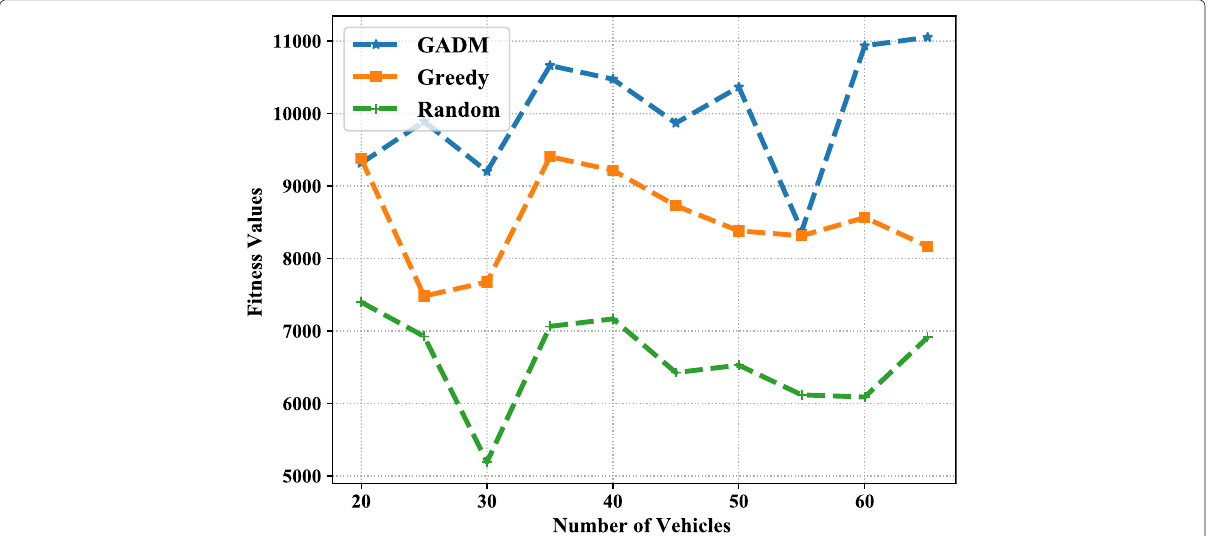
Fig. 11 Fitness values with different number of vehicles